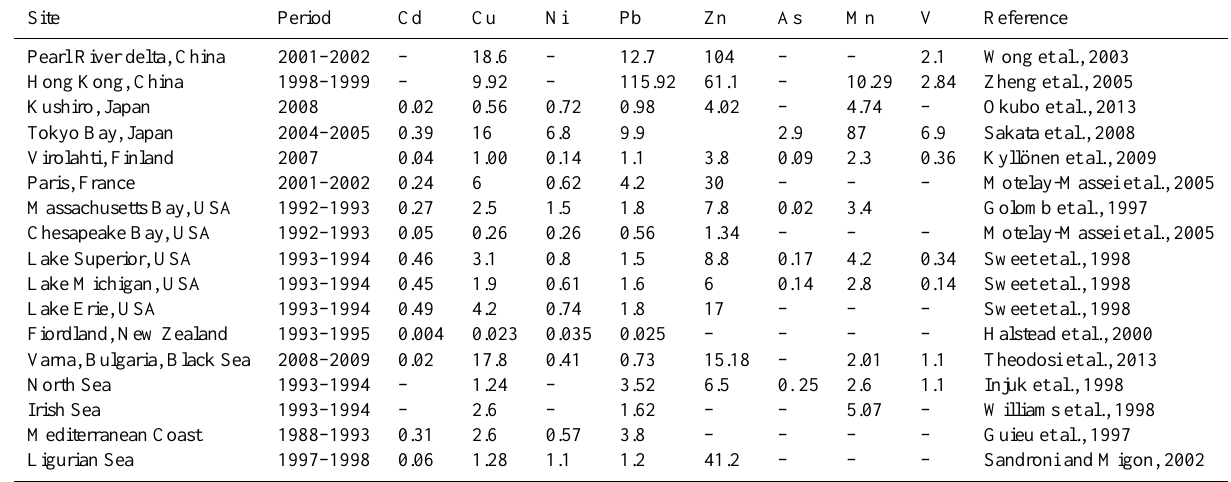
Table 5. Atmospheric total deposition fluxes of metals within and outside China (mgm − 2 yr − 1 ).